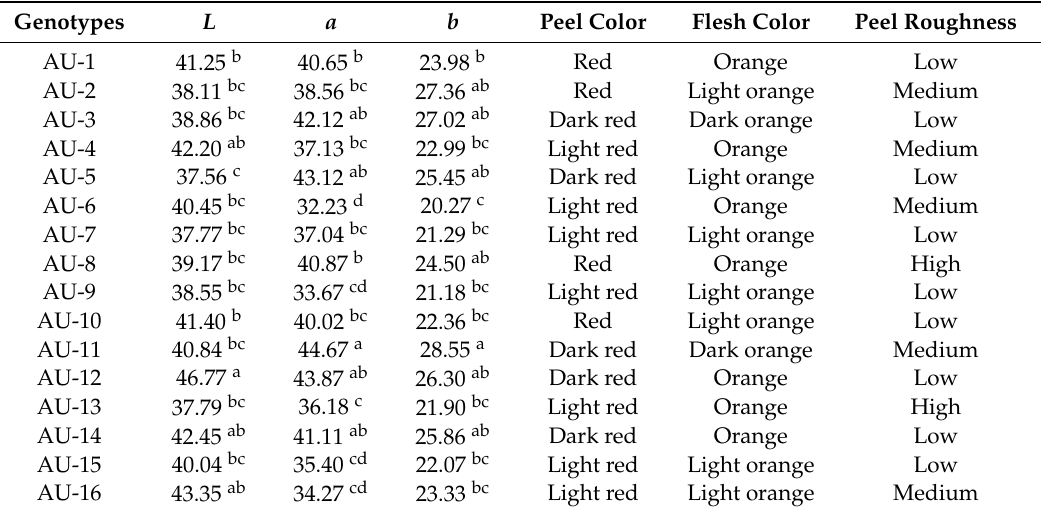
Table 2. Some color and roughness characteristics of fruits belonging to the strawberry tree (average of 2017–2018